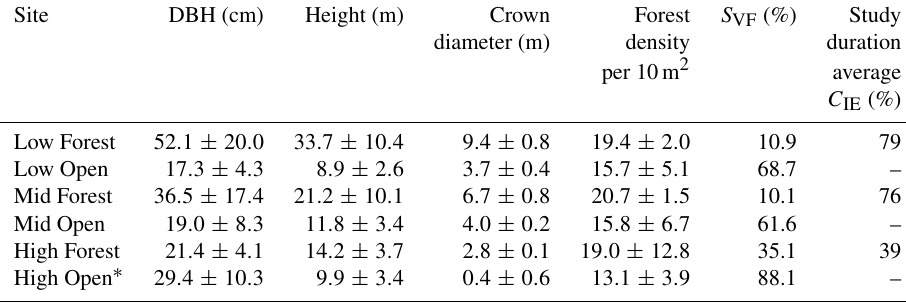
Table 1. Site forest characteristics with the associated SD for each